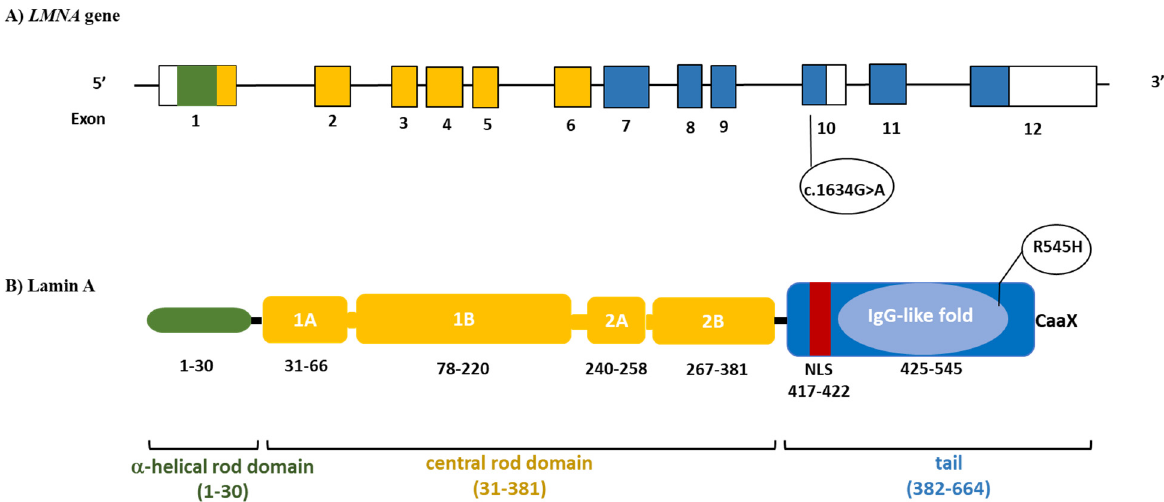
Figure 1. Schematic structure of LMNA . In the upper panel, filled boxes indicate the exons of the gene ( A ). Protein domains are displayed color-coded in the lower panel ( B ). The heterozygous LMNA variant detected is also reported. NLS, nuclear localisation signal.